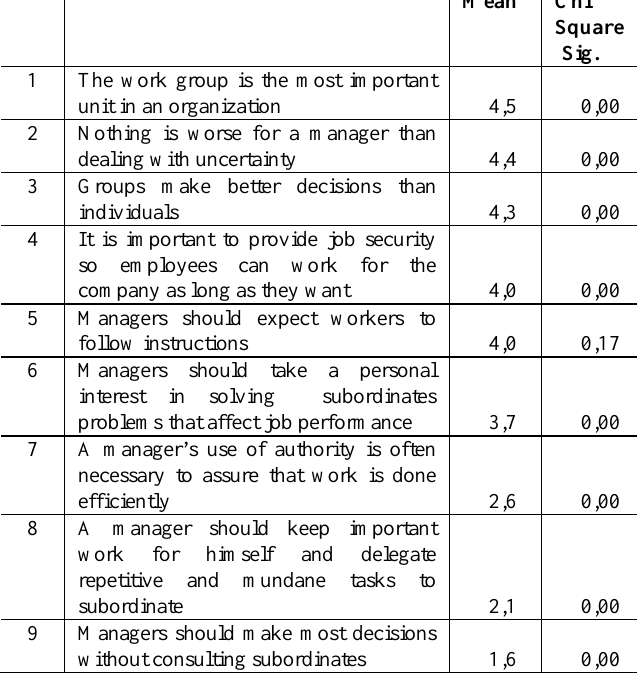
Table 5: Managerial philosophy